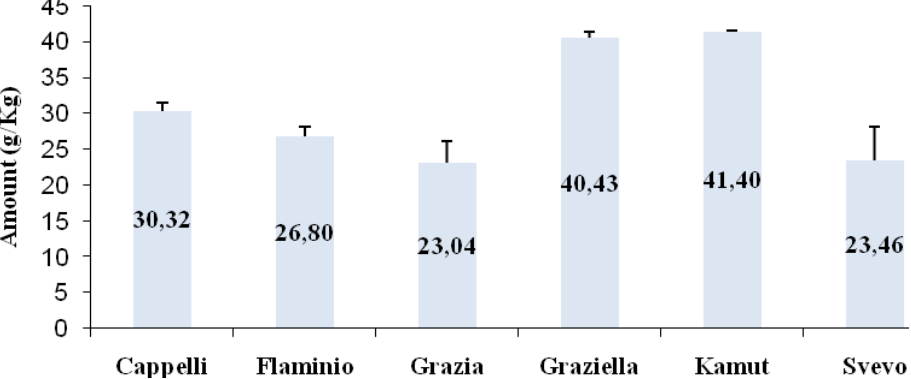
Figure 1. Total gliadin determination by a two step sandwich ELISA. All values are reported as mean ± SD from three independent experiments.